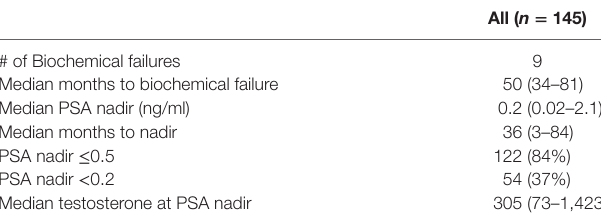
TaBle 2 | PSA outcomes at a median follow-up of 5.6